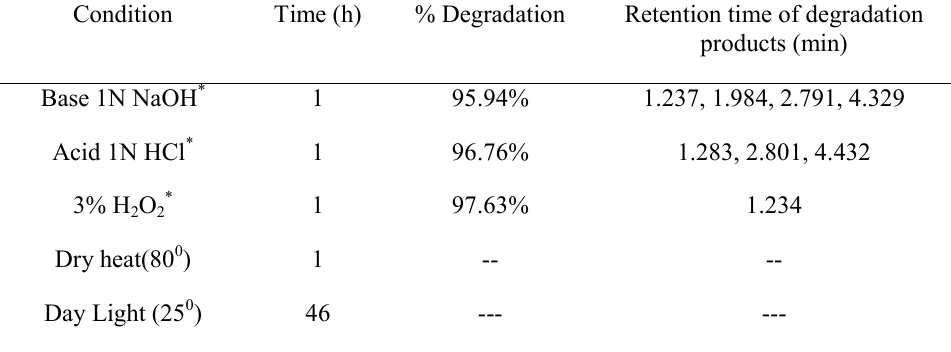
Table 4. Stress study data of Fexofenadine.